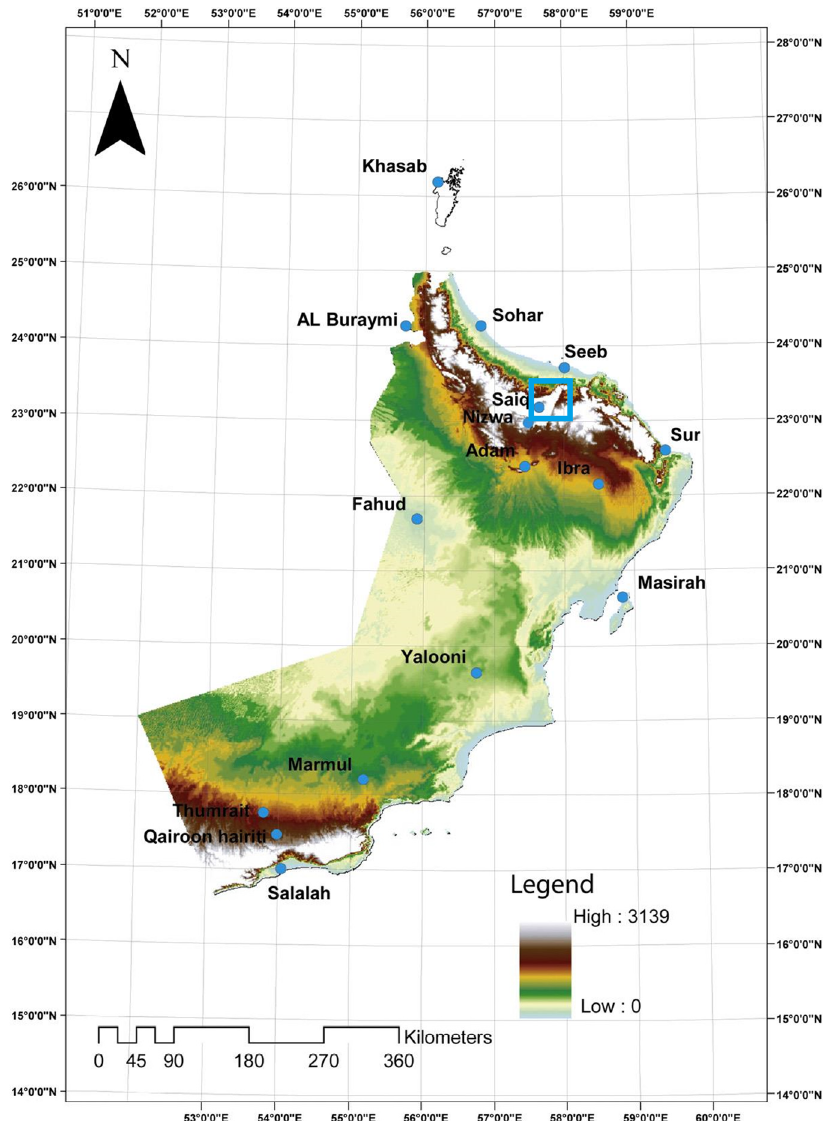
Figure 1. Oman map showing the location of Al Jabal Al Akhdar (in blue